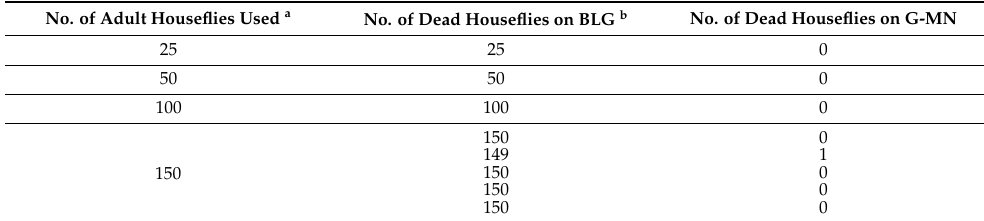
Table 3. Evaluation of the ability of the arc-discharge exposer (ADE) to control successive invasions by adult